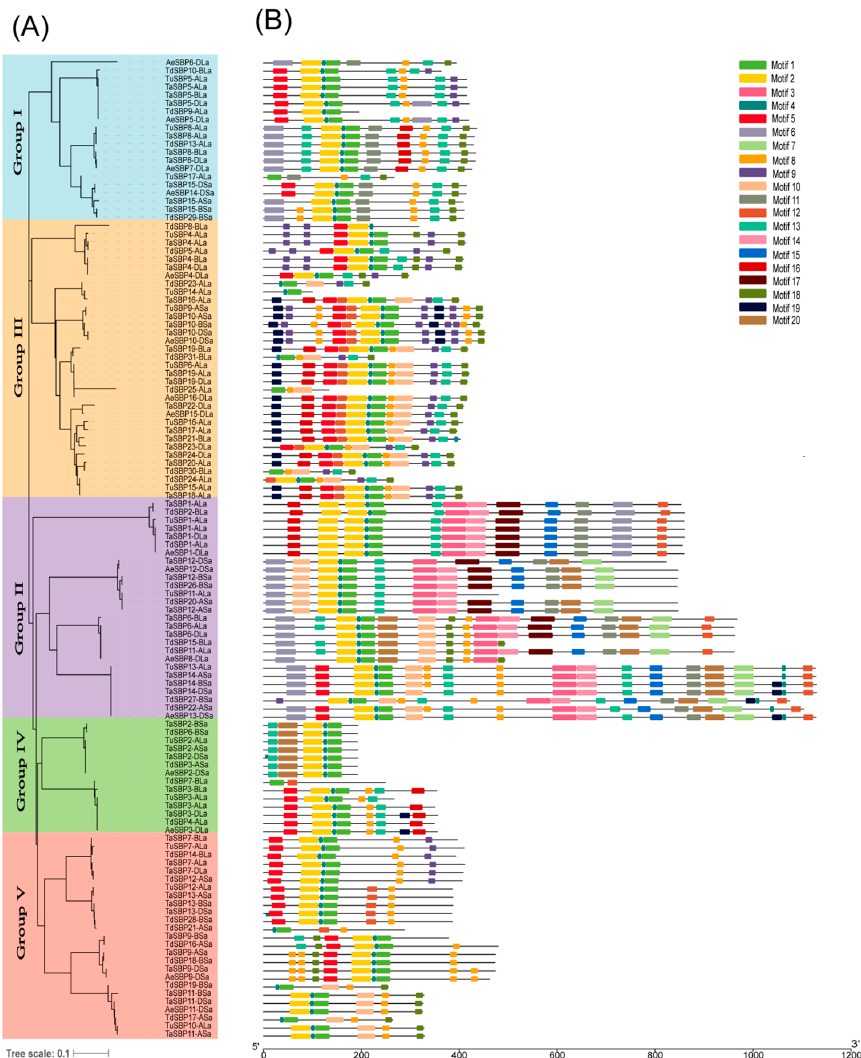
Figure 2. Comparative analysis of the phylogenetics, exon–intron structure, and conserved motifs of SBP family in wheat. ( A ) The phylogenetic tree of 120 SBP proteins (from Aegilops tauschii (16), Triticum urartu (17), Triticum dicoccoides (31), and hexaploid wheat (56, only protein translated from the splice variant “a” of each wheat SBP gene was considered here)) were constructed by using MEGA 7.0. ( B ) Motif composition models of 120 SBP proteins. Di ff erent motifs are color-coded. The gene order in ( B ) is similar to ( A